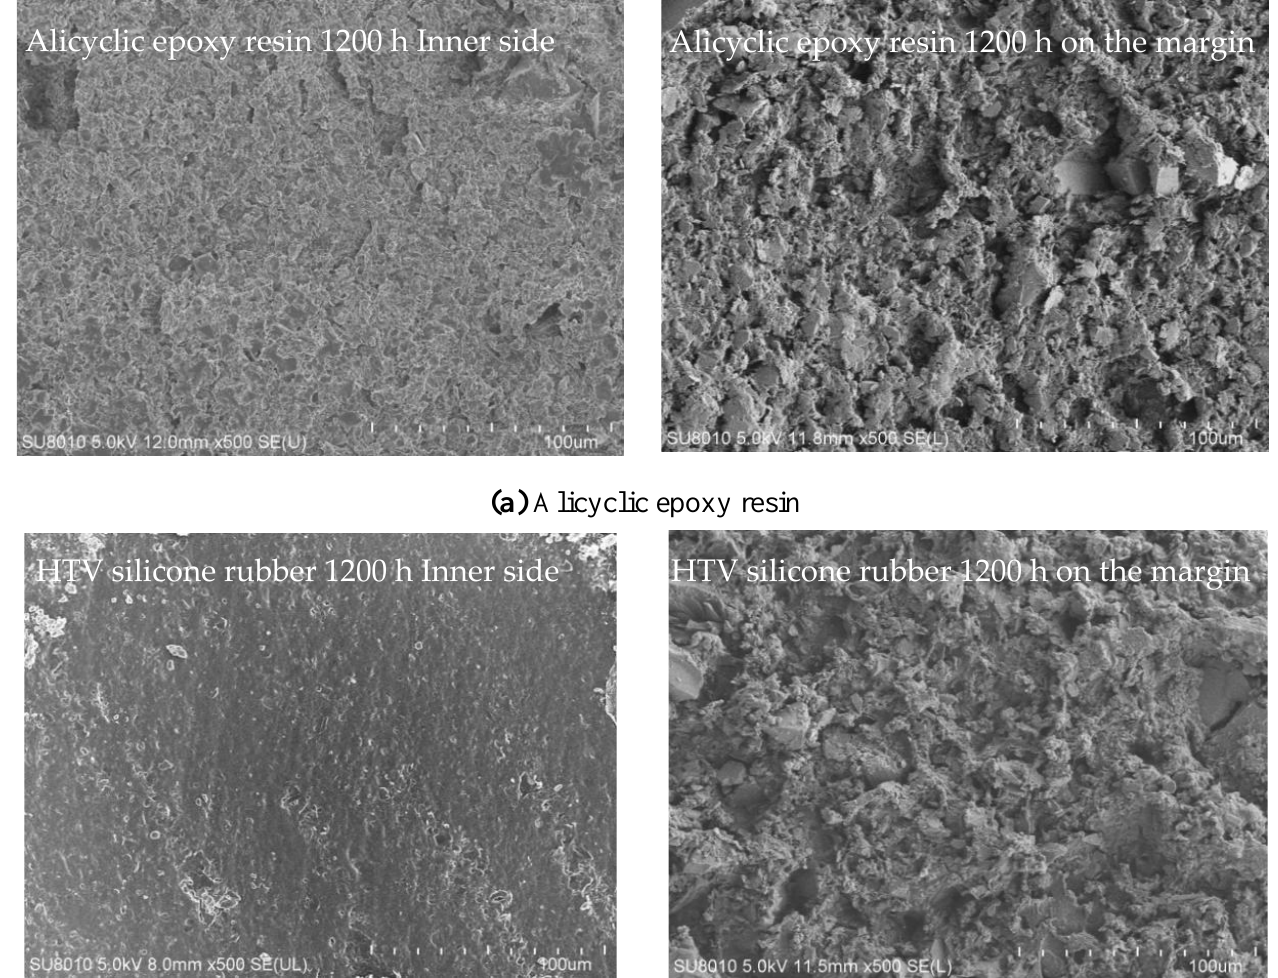
( b ) Figure 6. Tensile and elongation at break of two samples: (a) alicyclic epoxy resin; (b) HTVSR.